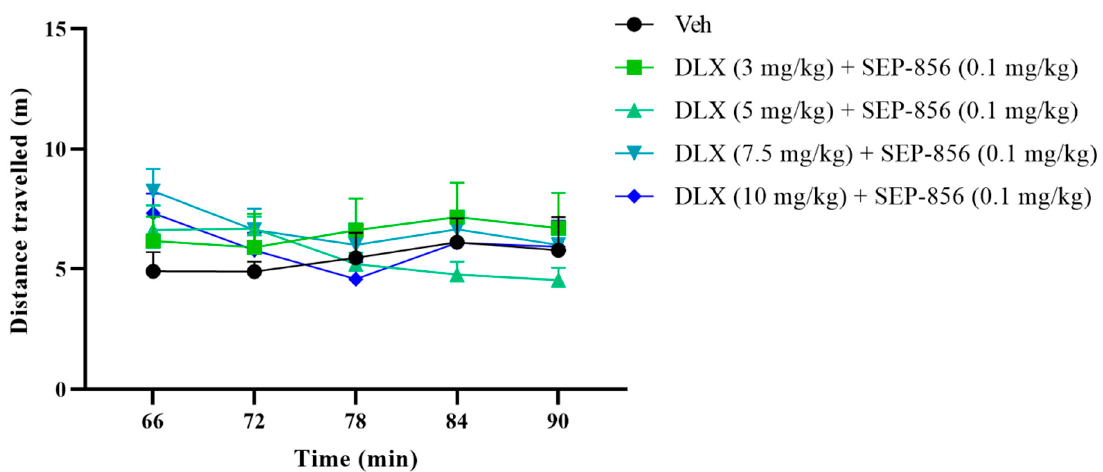
Figure 3. Effects of administration of duloxetine (3, 5, 7.5, and 10 mg/kg) and SEP-856 (0.1 mg/kg) on the locomotor activity of ICR mice. The test was performed 60 min after administration. Values are expressed as the mean ± SEM. from 8 mice and were analyzed using repeated-measures ANOVA followed by Bonferroni’s multiple comparisons test. DLX, duloxetine.